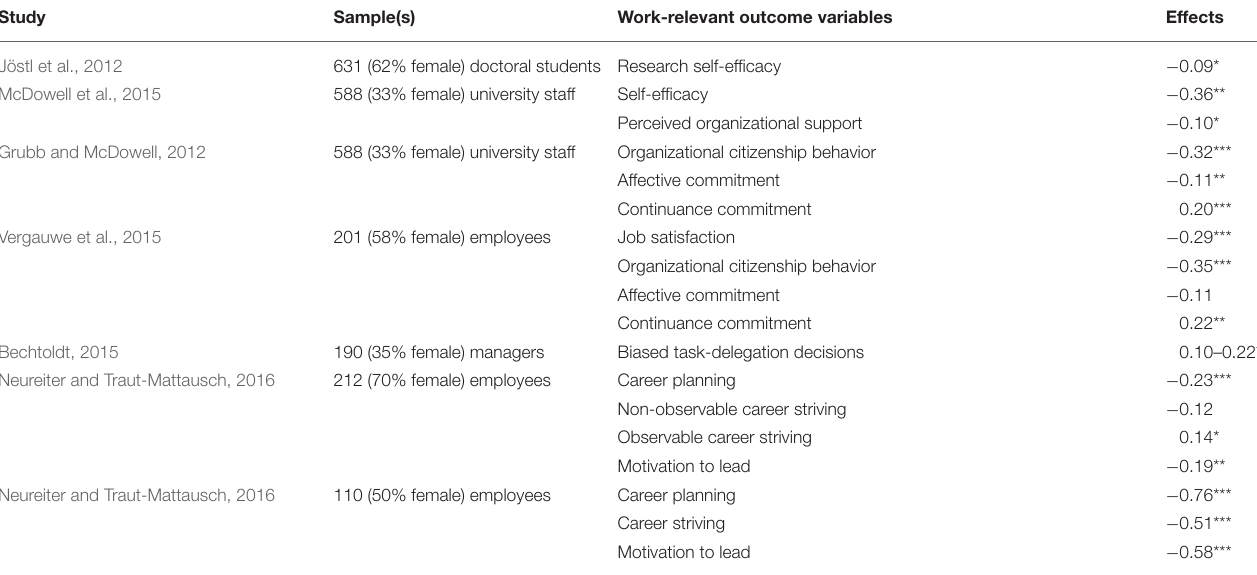
TABLE 1 | Summary of studies investigating the impostor phenomenon and work-relevant